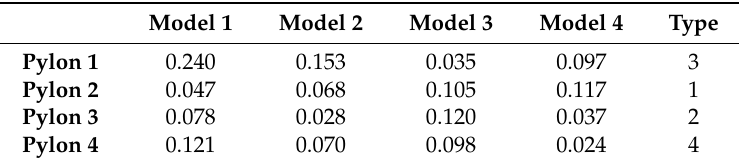
Table 6. Matching Cost matrix between the head points and models T.